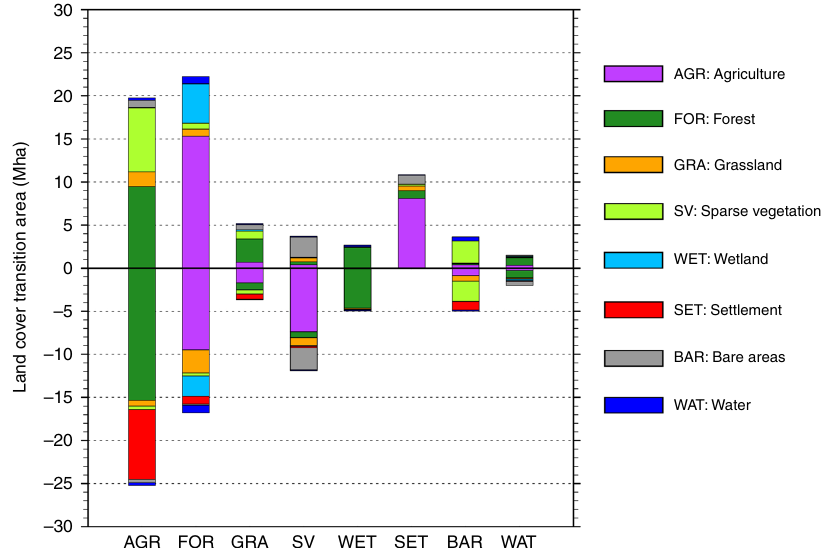
Fig. 1 Land cover changes occurred in Europe between 1992 and 2015. Positive values indicate an expansion of the respective land cover, negative values a contraction. The CCI-LC classi fi cation system is converted to the IPCC land classes to facilitate interpretation. See Supplementary Table 3 for the cross- walking table translating from one land classi fi cation system to the other. Supplementary Fig. 1 shows the maps of the major land cover